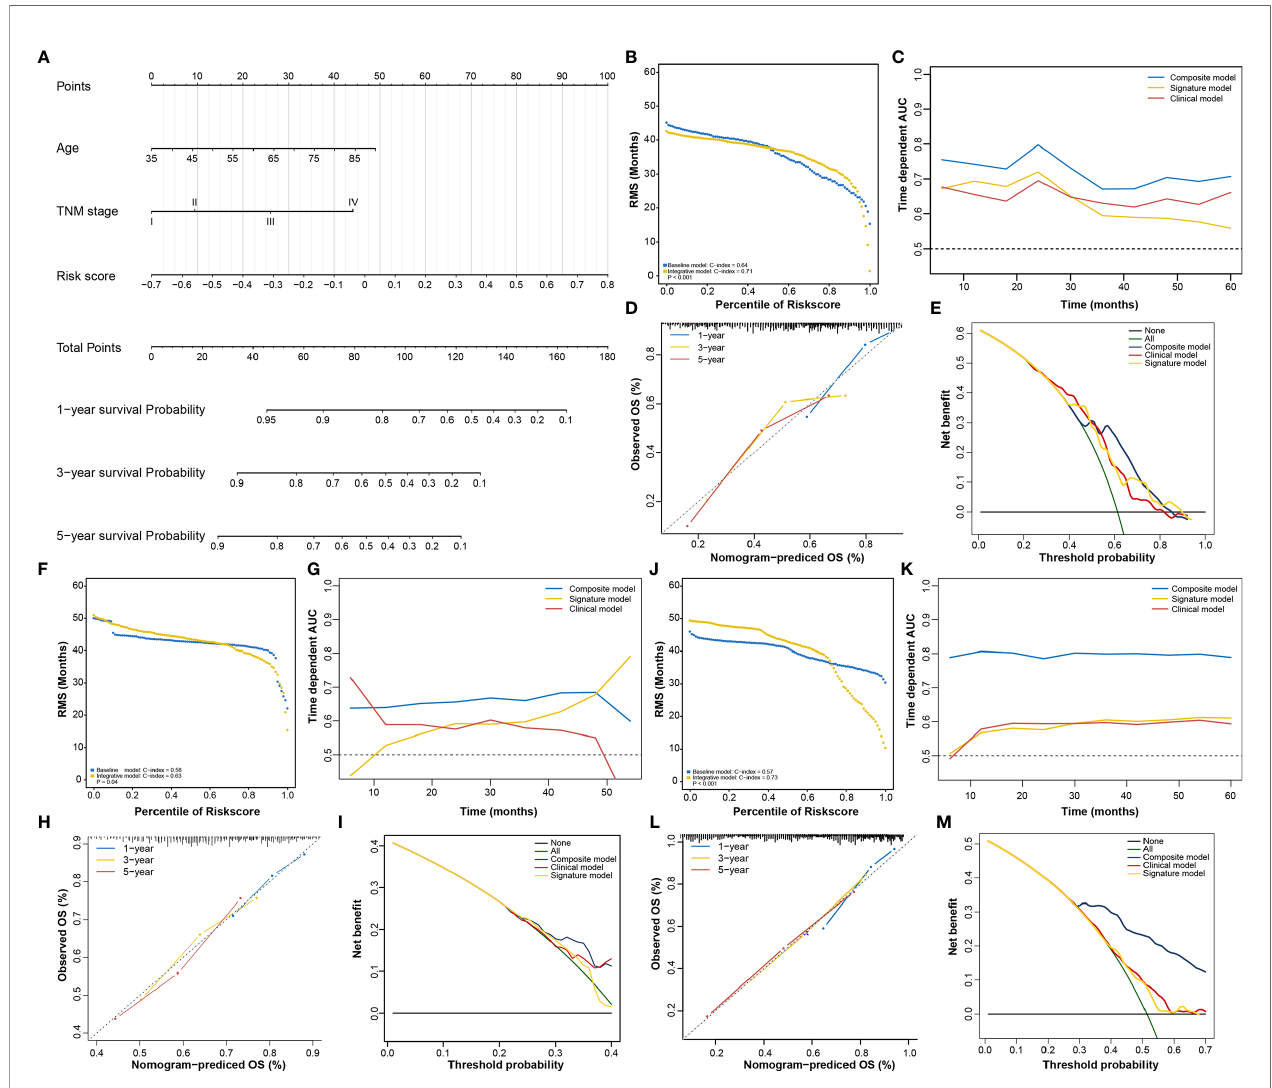
FIGURE 3 | Identi fi cation of the composite prognostic nomogram. (A) Composite nomogram prediction of 1-year, 3-year, and 5-year OS. (B, F, J) RMS curves for the composite prognostic nomogram and clinical model in the training and validation datasets. (C, G, K) Time-dependent ROC curves for the nomogram, signature model, and clinical model at different time points in the training and validation datasets. (D, H, L) Calibration curves of observed and predicted probabilities for the nomogram in the training and validation datasets. (E, I, M) DCA curves for the nomogram in the training and validation